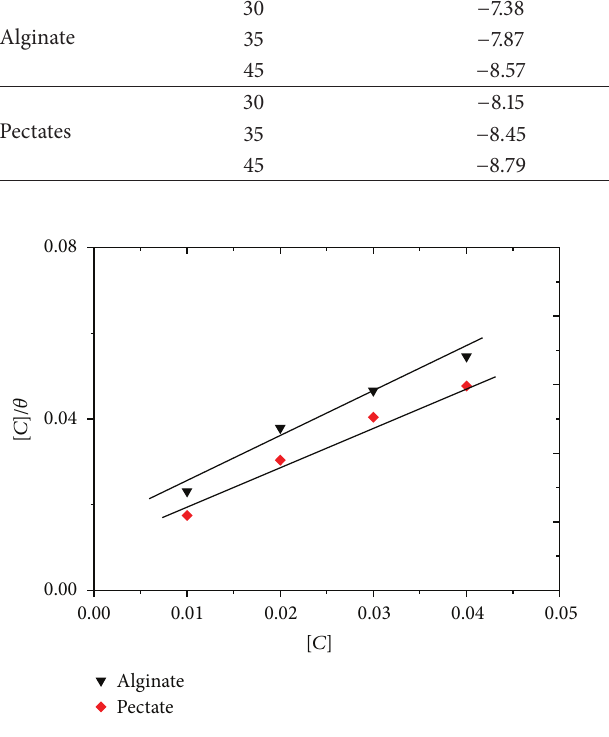
Figure 6: A plot of Langmuir isotherm for corrosion of Al in alkaline media at 35 ∘ C.